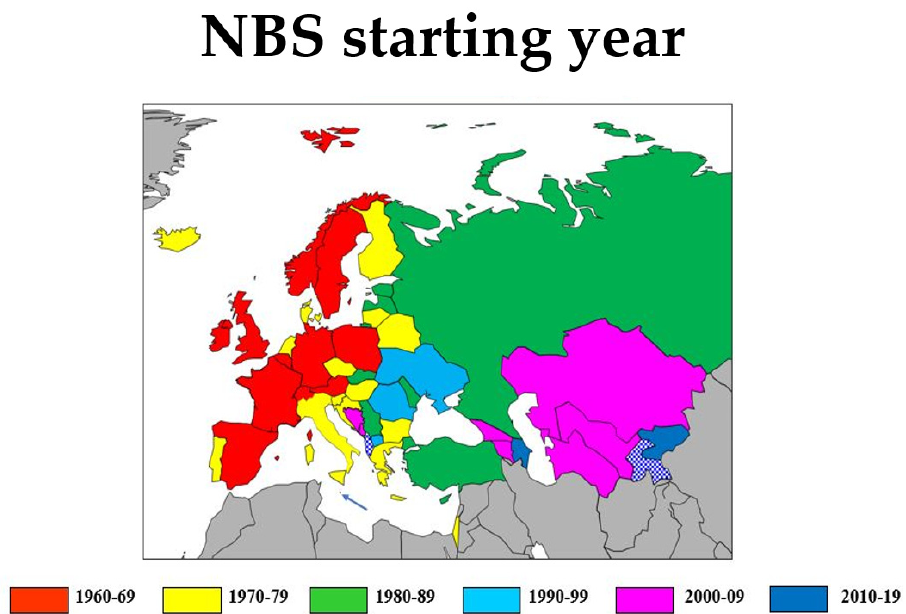
Figure 1. Map of the International Society for Neonatal (ISNS) European region, colour coded by the starting year of neonatal screening. Arrow indicates Malta (green). Albania and Tajikistan (in blue-hatched white) have no neonatal screening programme. Grey areas fall outside the geographical region under consideration. White areas are bodies of water.